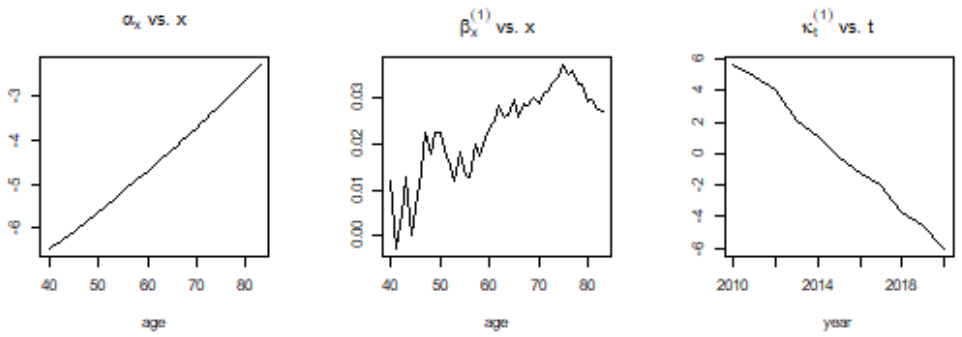
Figure 3. Lee–Carter Parameters Fitted to the Ghana Pension Population for Ages 40–83 and the Period 2010–2020.